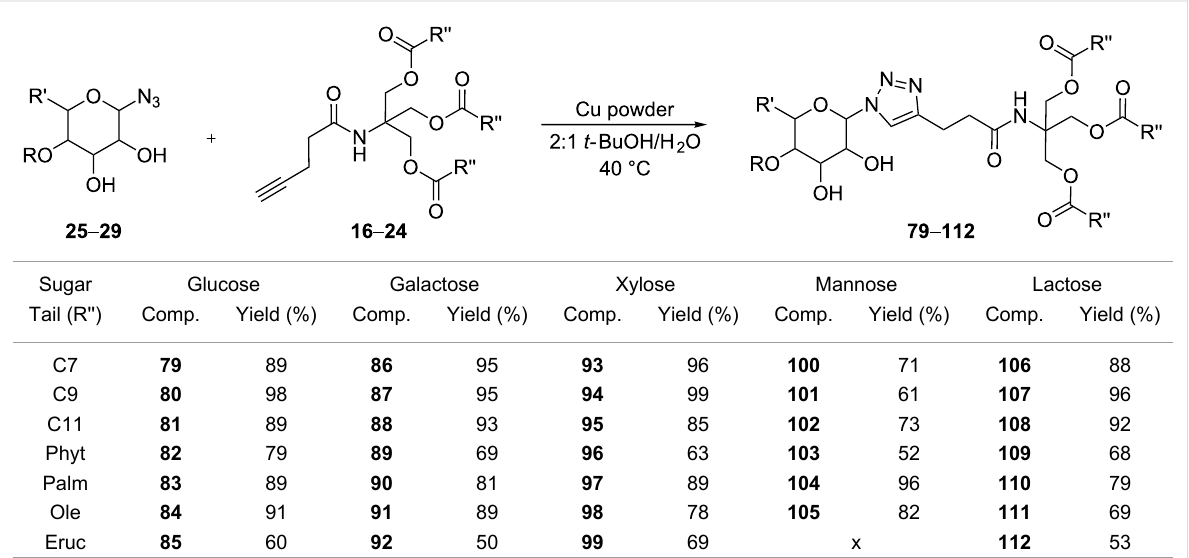
Table 3: Synthesis of triple-chained amphiphiles. a